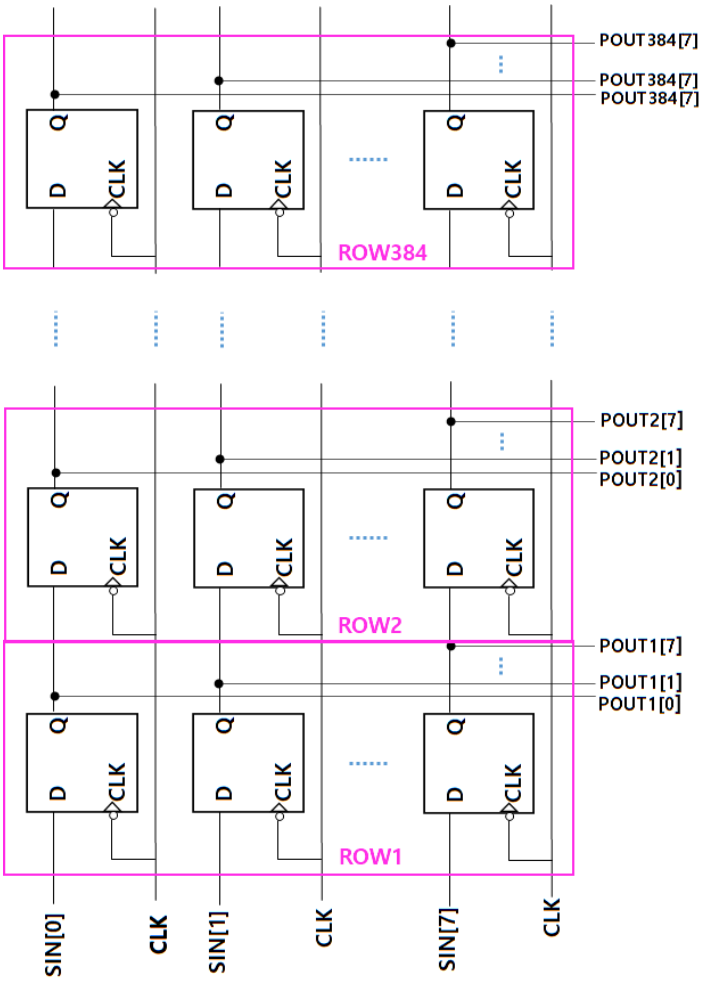
Figure 6. Deserializer circuit used in the first layer.